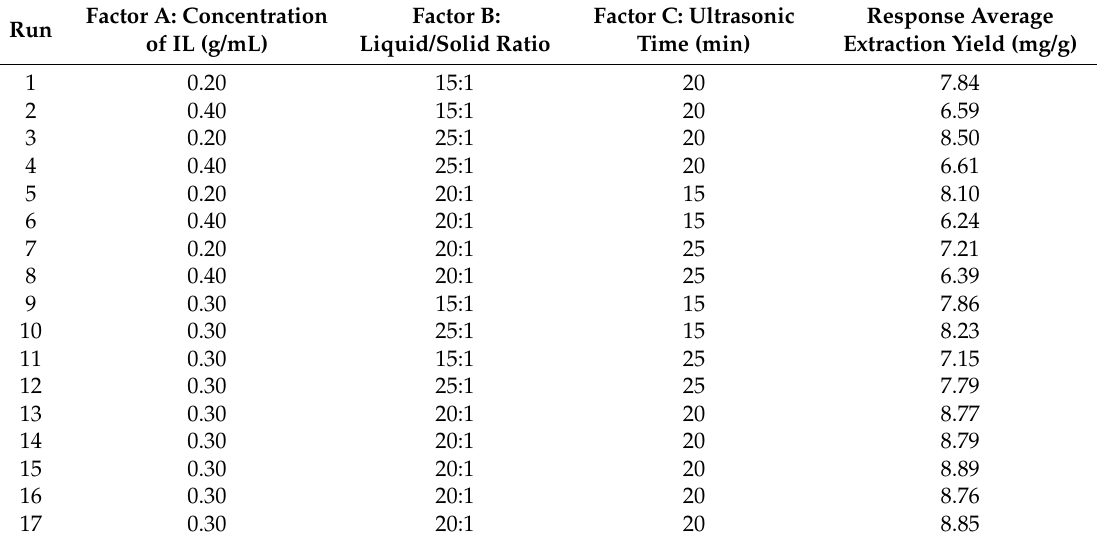
Table 1. Experimental conditions for extraction yield using a three-factors/three-level Box-Behnken